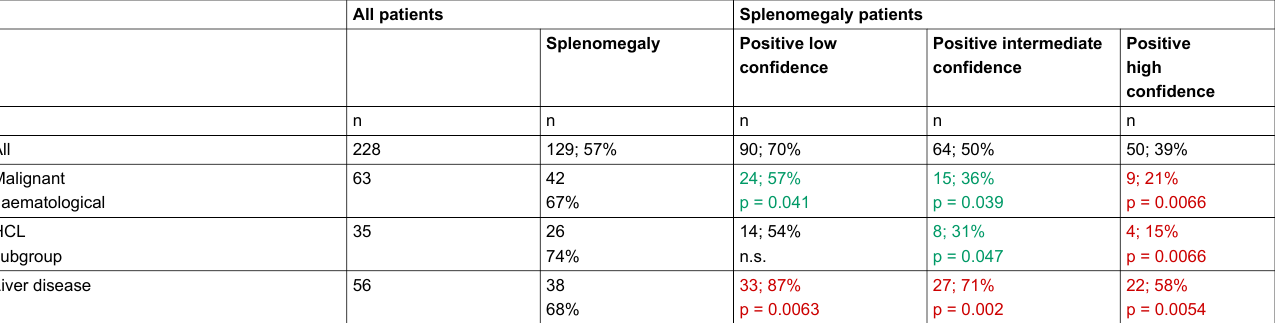
Table 3: Positive tests in different diagnosis groups. Patients were analysed according to their underlying diagnosis. The percentage of patients with splenomegaly is given; the subsequent analysis is restricted to these splenomegaly patients. For each level of confidence the number of positive tests is given and significance of any difference versus the remaining patient population calculated (Fisher’s exact test). Significant differences are indicated in green (p <0.05), very significant differences in red (p